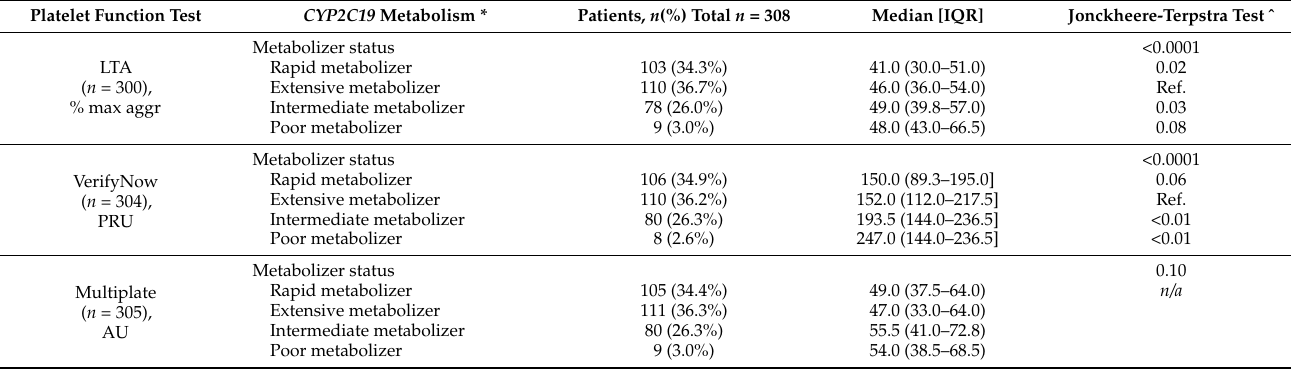
Values are expressed as median with interquartile range (IQR). Categorical data are expressed as absolute numbers and percentages ( n (%)). n/a; not applicable (pairwise comparisons are not performed because the overall test does not show significant differences across groups). * Poor metabolizers have genotype CYP2C19*2/*2 , intermediate metabolizers CYP2C19*1/*2 , *1/*3 , or *2/*17 , extensive metabolizers CYP2C19*1/*1 , and rapid metabolizers CYP2C19*1/*17 or *17/*17 . ˆ Jonckheere–Terpstra test for ordered alternatives, with pairwise comparisons for the different metabolizer groups compared to extensive metabolizers (reference